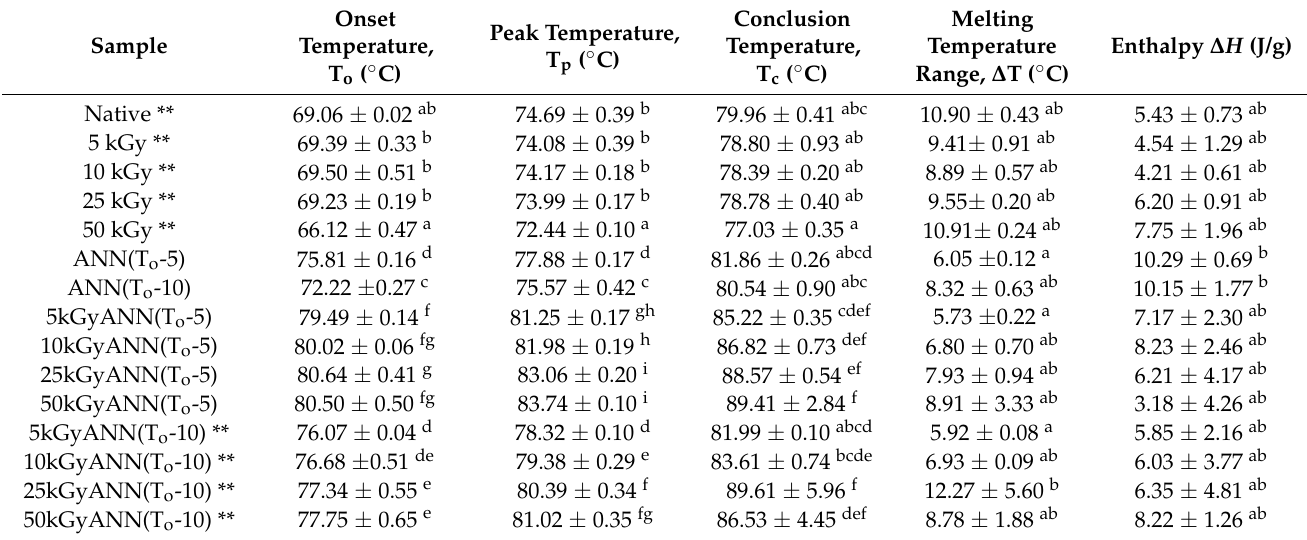
Table 3. Gelatinization parameters of native and modified sago